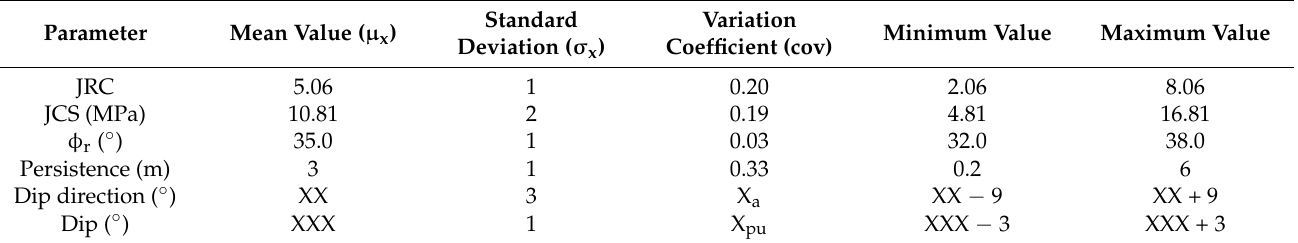
Table 1. Input parameters for probabilistic stability analysis.